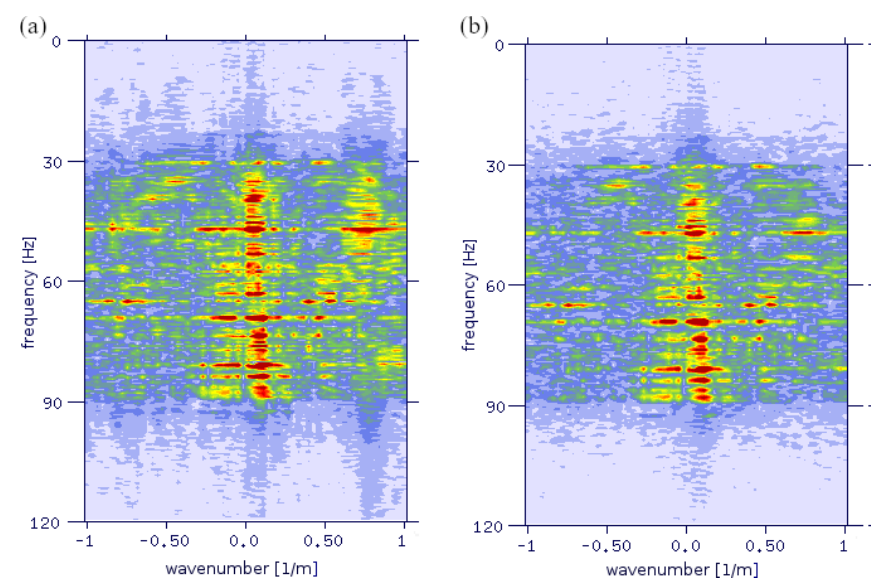
Figure 4. The FK spectra before (a) and after (b) the velocity filtering. The FK amplitudes are plotted with the same colour scale.